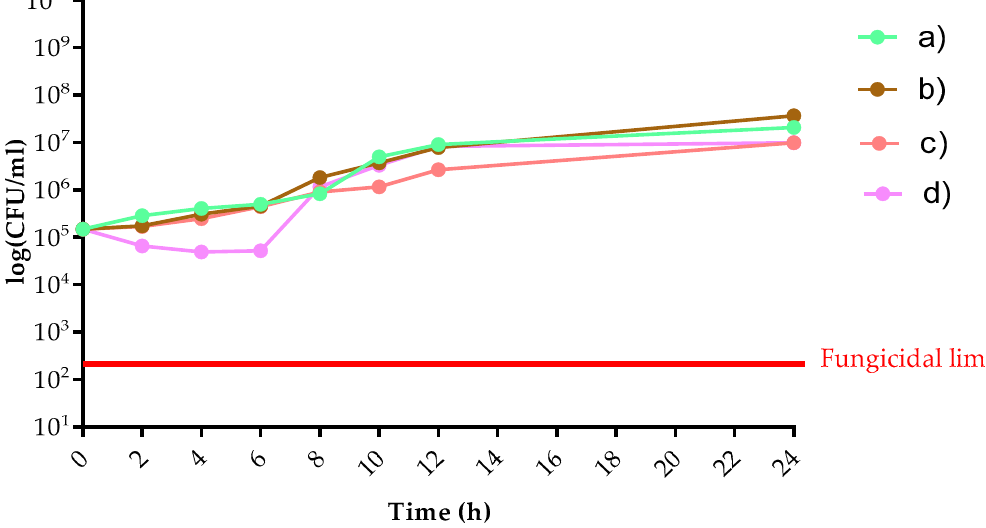
Figure 13. The logarithmical colony ‐ forming unit (CFU)/mL in case of C. albicans versus time (h) where ( a ) empty vaginal ring; ( b ) metronidazole containing vaginal ring; ( c ) 3 w/w % chitosan and 4 w/w % hydroxyethyl cellulose containing vaginal ring; ( d ) 3 w/w % chitosan and metronidazole containing vaginal ring.